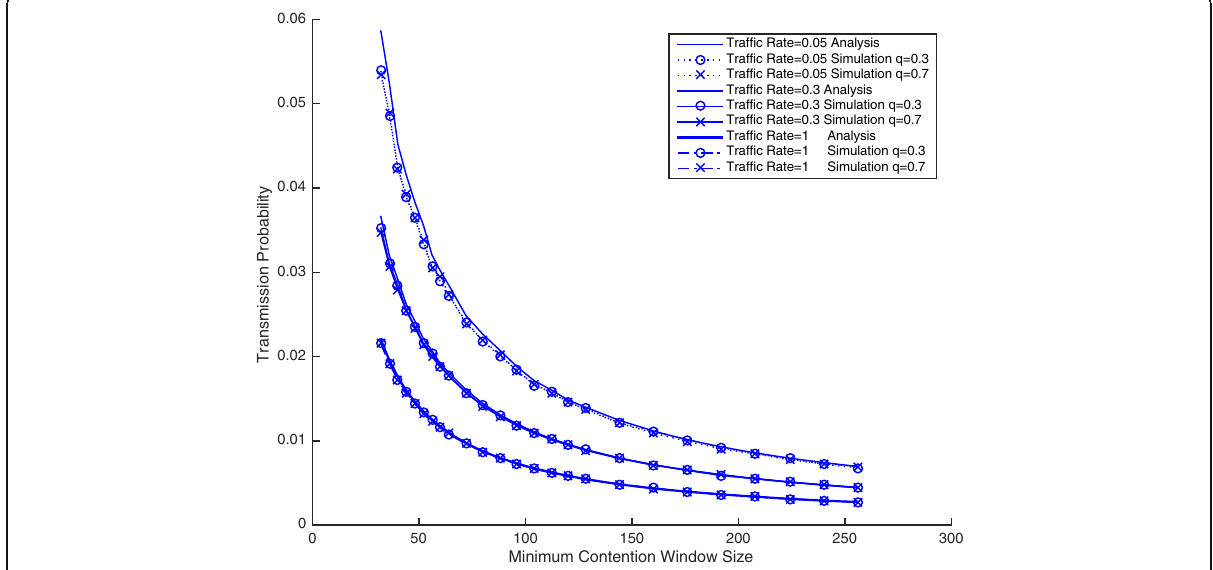
Fig. 3 Minimum window vs transmission